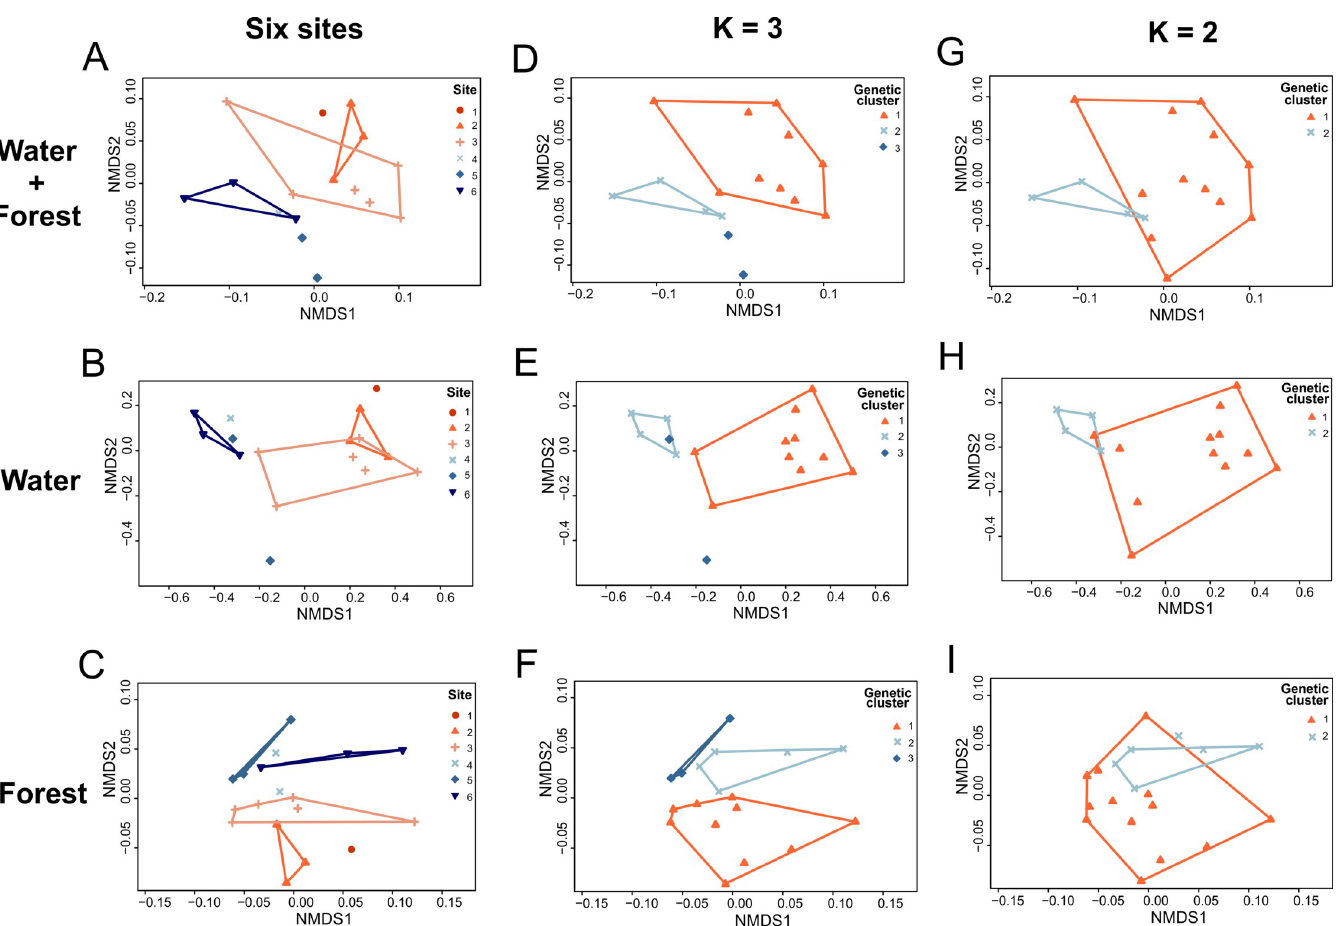
Fig 3. Non-metric Multidimensional Scaling (NMDS) results depicting sample points and the convex hulls for ecological datasets. Three datasets were used: variables of breeding streams of Mantidactylus bellyi and forest areas surrounding them analyzed together in the first row, separate analyses of the breeding streams variables in the second row, and separate analyses of the forest variables in the third row. Dots represent ecological sample points. They were colored according to their assignment to one of the six sites in the first column, to a genetic subpopulation cluster as in the K = 3 STRUCTURE models in the second column, to a genetic subpopulation cluster as in the K = 2 STRUCTURE model (No admixture/LOCPRIOR) in the third column.